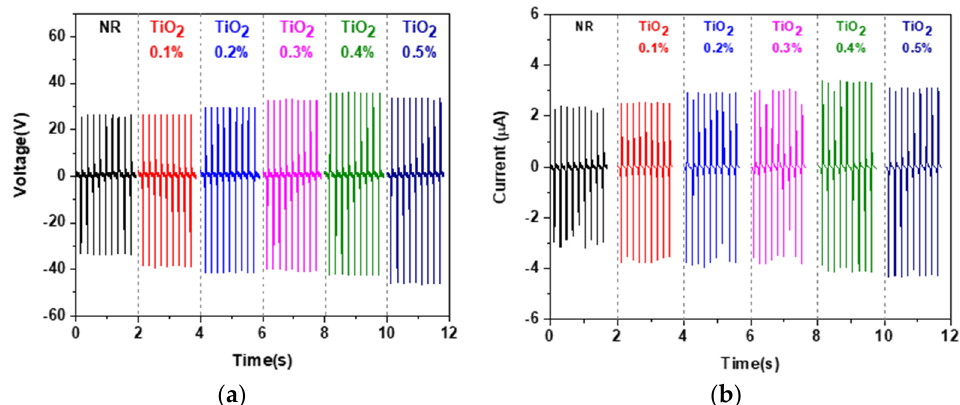
Figure 2. ( a ) Electrical output voltage and ( b ) current of the NR-TiO 2 0.1–0.5%wt.